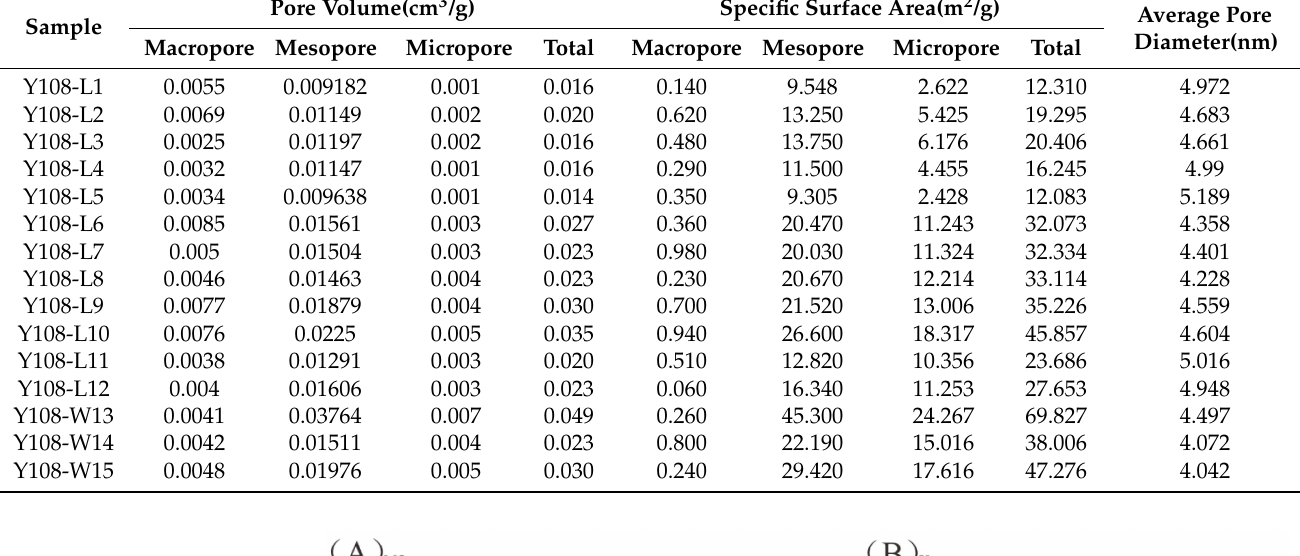
Table 4. Pore volumes and SSAs of Wufeng–Longmaxi Fm shales depend on MIP and N2/CO 2 isotherms.